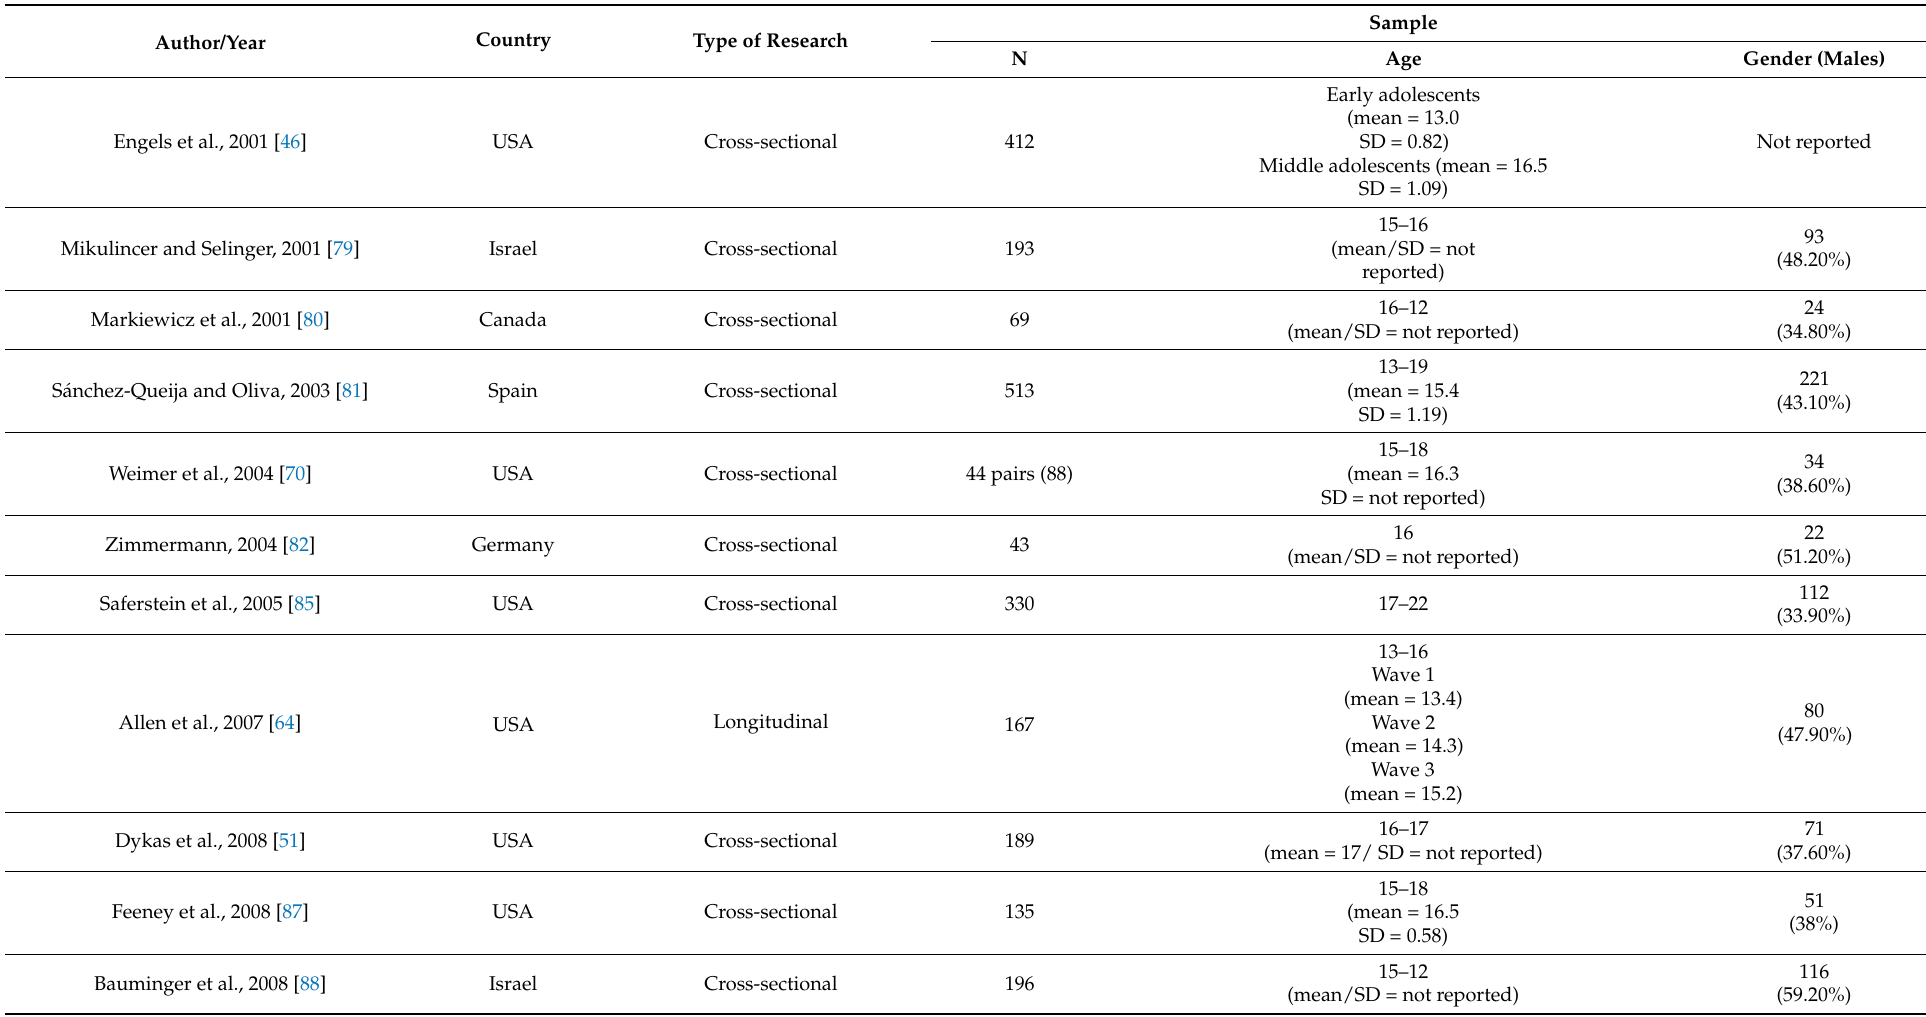
Table 1. Descriptive characteristics of included